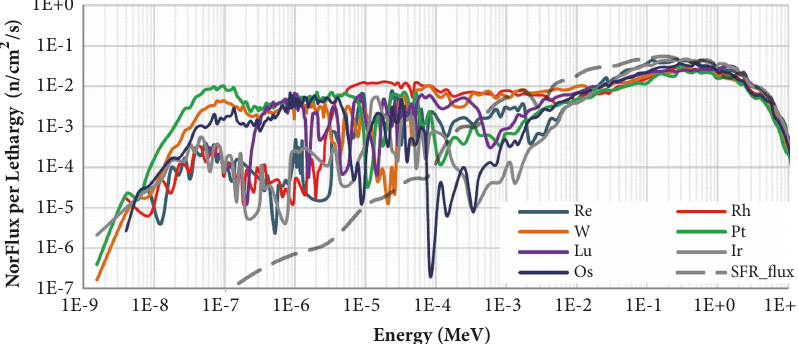
Figure 12: Effect of 3.4 cm Re, Rh, W, Pt, Lu, Ir, and Os neutron screens on the neutron spectrum. All screens provide a sufficient neutron spectrum shifting and broadening as well as thermal component cutoff.